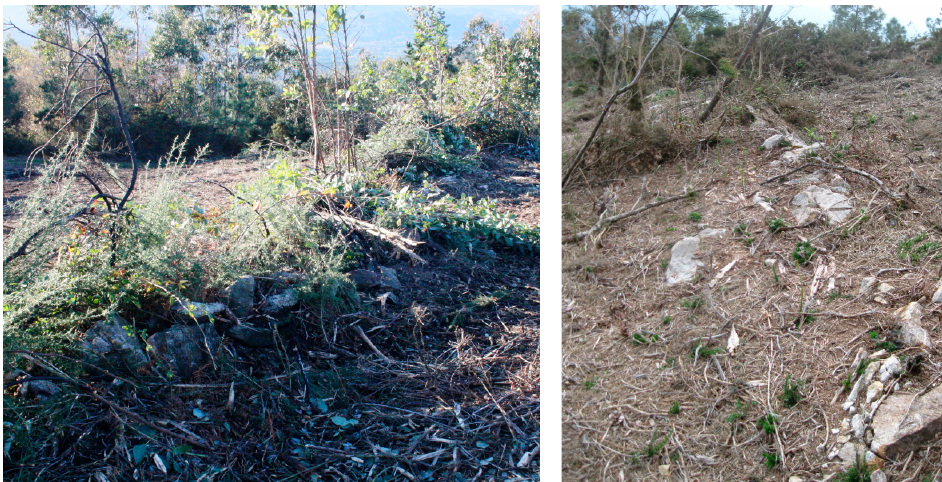
Figure 3. Dry stone sections of the Frojám enclosure (Photographs: Joám Evans Pim).